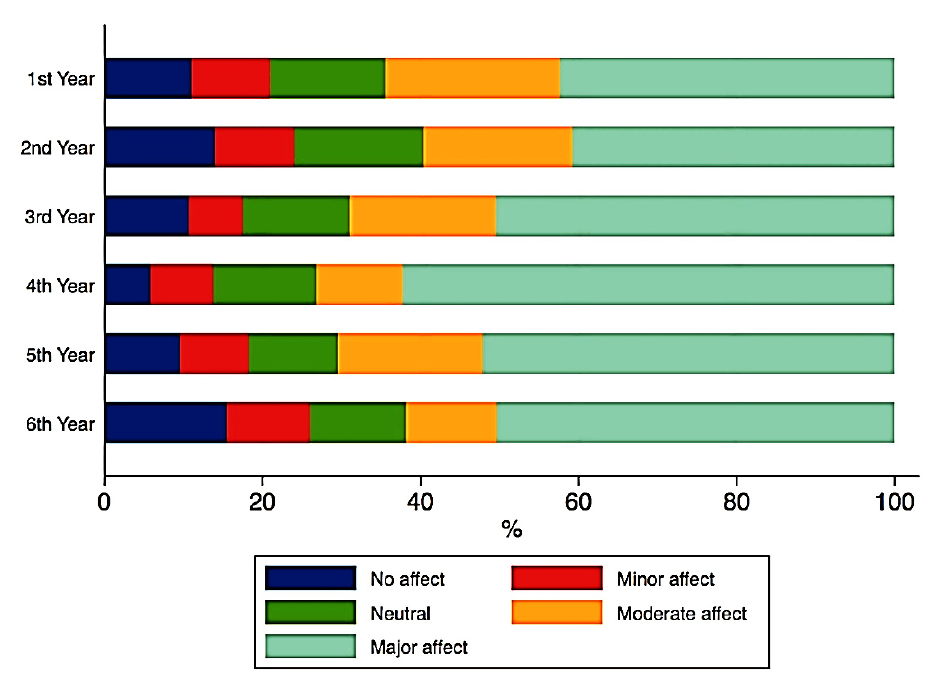
Figure 4. Gain of practical skills.